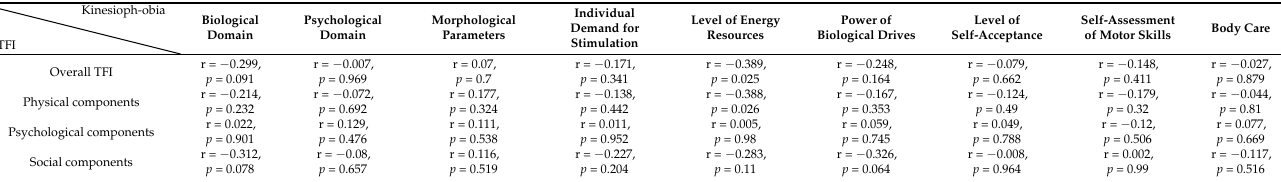
Table 5. Correlation between the TFI subscale and kinesiophobia in women.